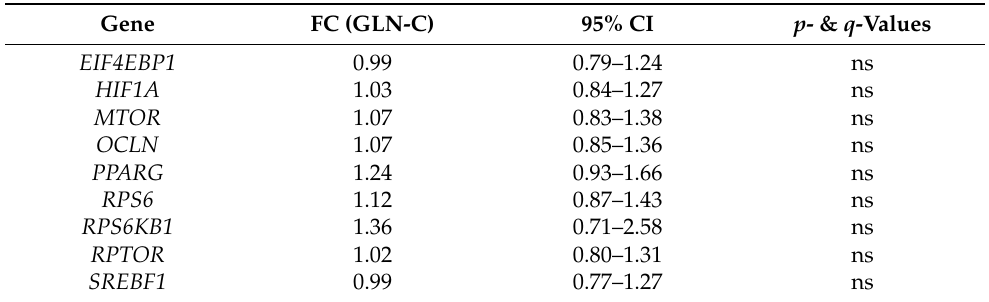
Table 5. Expression of target genes in control (C) and treated (GLN) pigs at the slaughterhouse. Gene FC